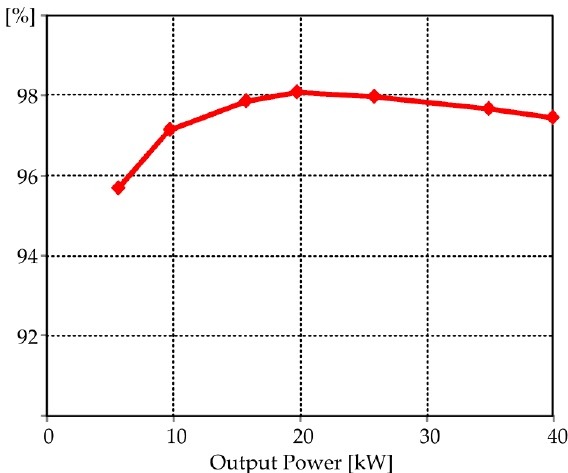
Figure 16. Measured efficiency versus output power of the DAB DC-DC converter with the second MFT prototype.